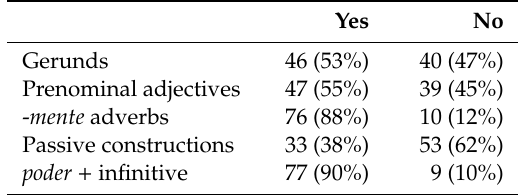
Table 3. Students’ responses to whether they deemed the features acceptable ( N = 430).